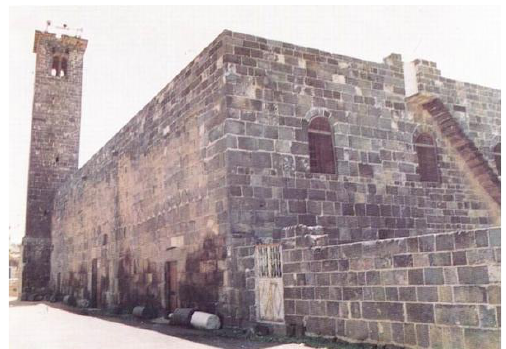
Figure 2. Al Omari Mosque, city of Bosra al-Sham (Syria) Five old images of the first monument, and thirteen images